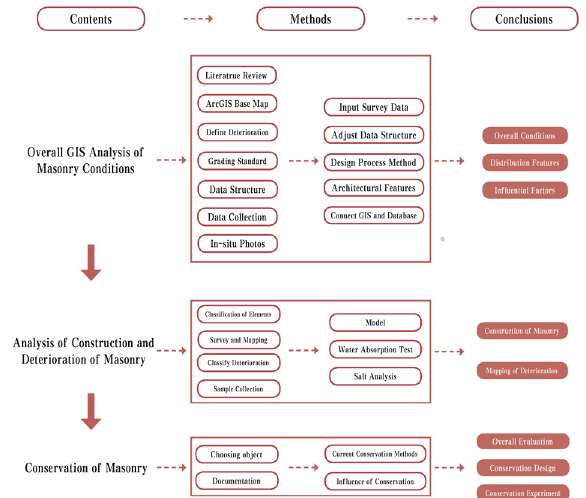
Figure 4. Technical route of the project.